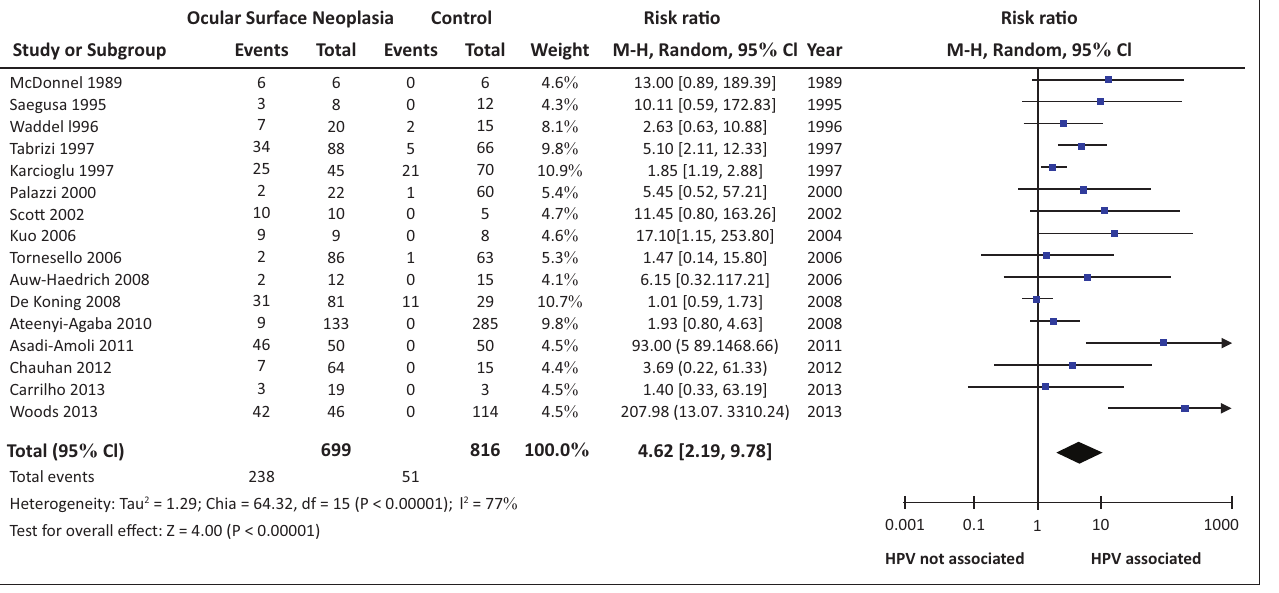
FIGURE 3: Forest plot showing the risk ratio for mucosal human papilloma virus as an association with ocular surface squamous neoplasia. The overall risk ratio was 4.62 and 95 % confidence interval: 2.19–9.78, with a high heterogeneity of studies.